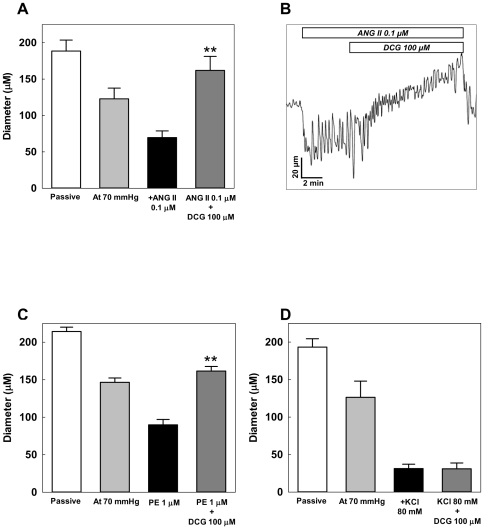
Effect of DCG on agonist-induced vasoconstriction.(A) At 70 mmHg, the arteries developed spontaneous vasoconstriction that was further augmented by adding ANG II (0.1 µM). DCG attenuated ANG II-induced vasoconstriction. (n = 5 arteries). (B) An example tracing of the effect of DCG on ANG II-induced vasoconstriction. (C) At 70 mmHg, the arteries developed spontaneous vasoconstriction that was further augmented by adding PE (1 µM). DCG attenuated PE-induced vasoconstriction. (n = 12 arteries). (D) DCG (100 µM) did not alter 80 mM KCl-induced vasoconstriction. (n = 3 arteries). Asterisks indicate significant differences when compared to ANG II and PE alone.